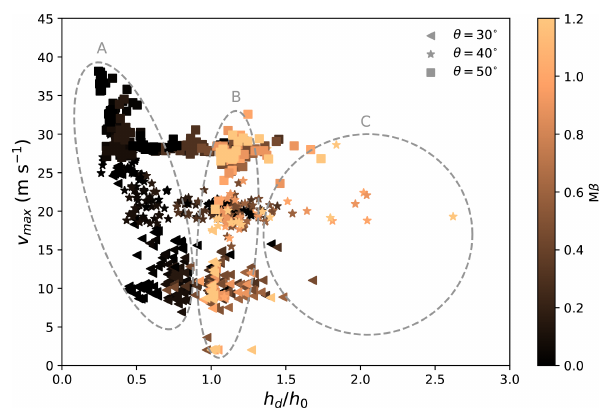
Figure 5. Evolution of the maximum velocity with the normalized deposit height for varying slope angles θ